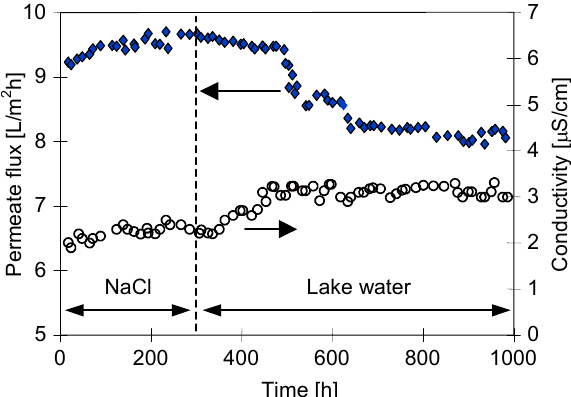
Figure 11. The changes of permeate flux and distillate conductivity during the MD process. Feed: 1 g NaCl/L and water from lake, T F = 333 K. Module MK1—Accurel PP S6/2. NaCl/L and water from lake, T F = 333 K. Module MK1—Accurel PP